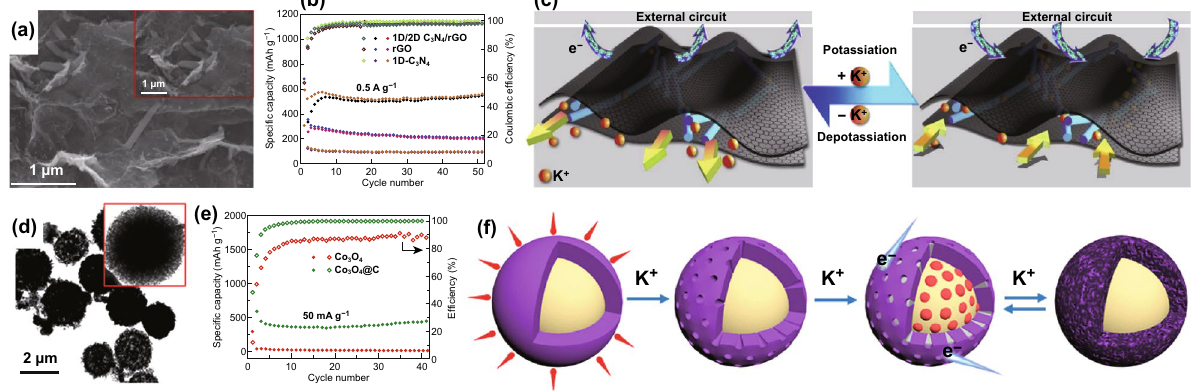
Fig. 21 a SEM image of 1D/2D C 3 N 4 /rGO. b Cycling performances and coulombic efficiency of 1D-C 3 N 4 , rGO and 1D/2D C 3 N 4 /rGO at of 0.5 A g −1 . c Possible mechanism of potassium storage in the 1D/2D C 3 N 4 /rGO composite. Reproduced with permission from Ref. [54]. d TEM and e comparison of the cycle life of Co 3 O 4 and Co 3 O 4 @N–C at 50 mA g −1 . f Scheme illustrating suggested potassiation and depotassiation mecha- nism of the Co 3 O 4 @N-C electrode. Reproduced with permission from Ref. [108]. Copyright permissions from Elsevier and American Chemical Society. (Color figure